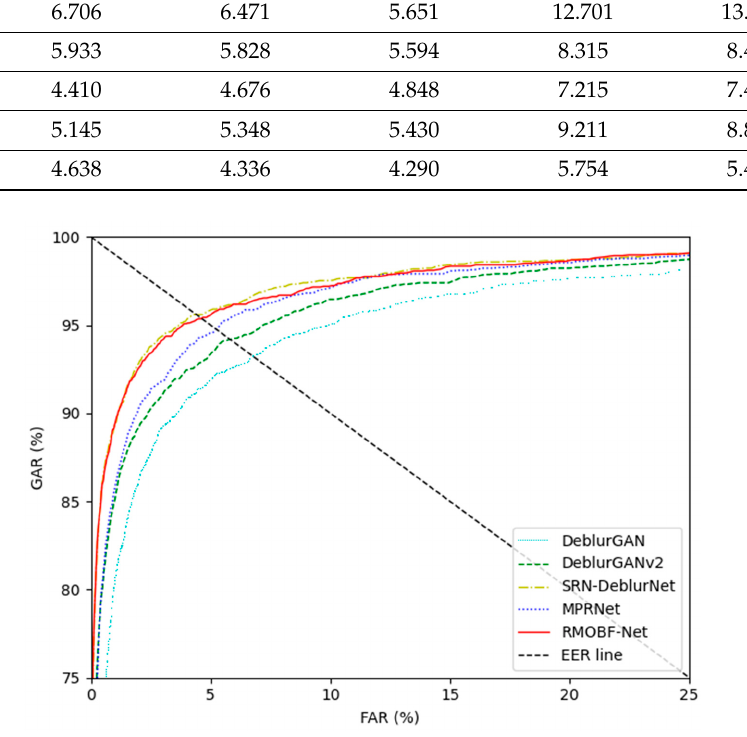
Figure 18. ROC curves of finger-vein recognition with SDU-DB for scheme 4 by various restoration methods (random motion blur and optical blur with intensity 11 × 11 (Gaussian filter size) and 11 (Gaussian filter standard deviation)).